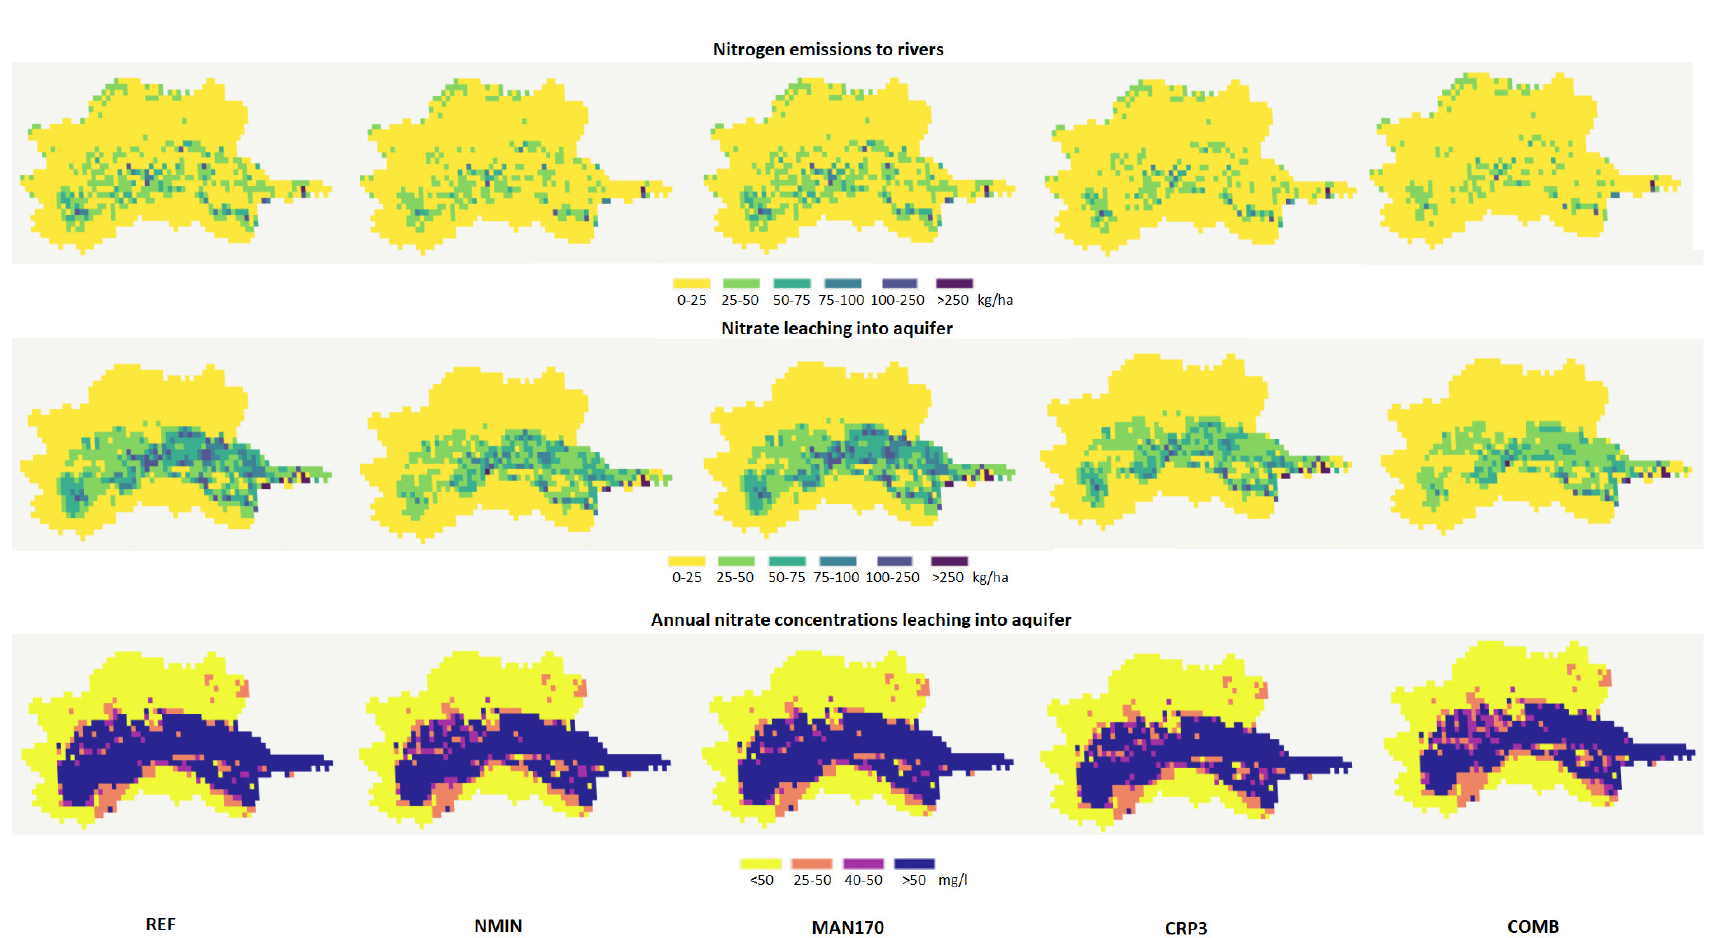
Figure 8. Spatial analysis of distribution of long-term mean of nitrogen emissions (kg/ha), nitrogen leached into aquifer (kg/ha) and nitrate concentration leached into aquifer for the baseline (REF) and scenarios NMIN, MAN170, CRP3 and COMB